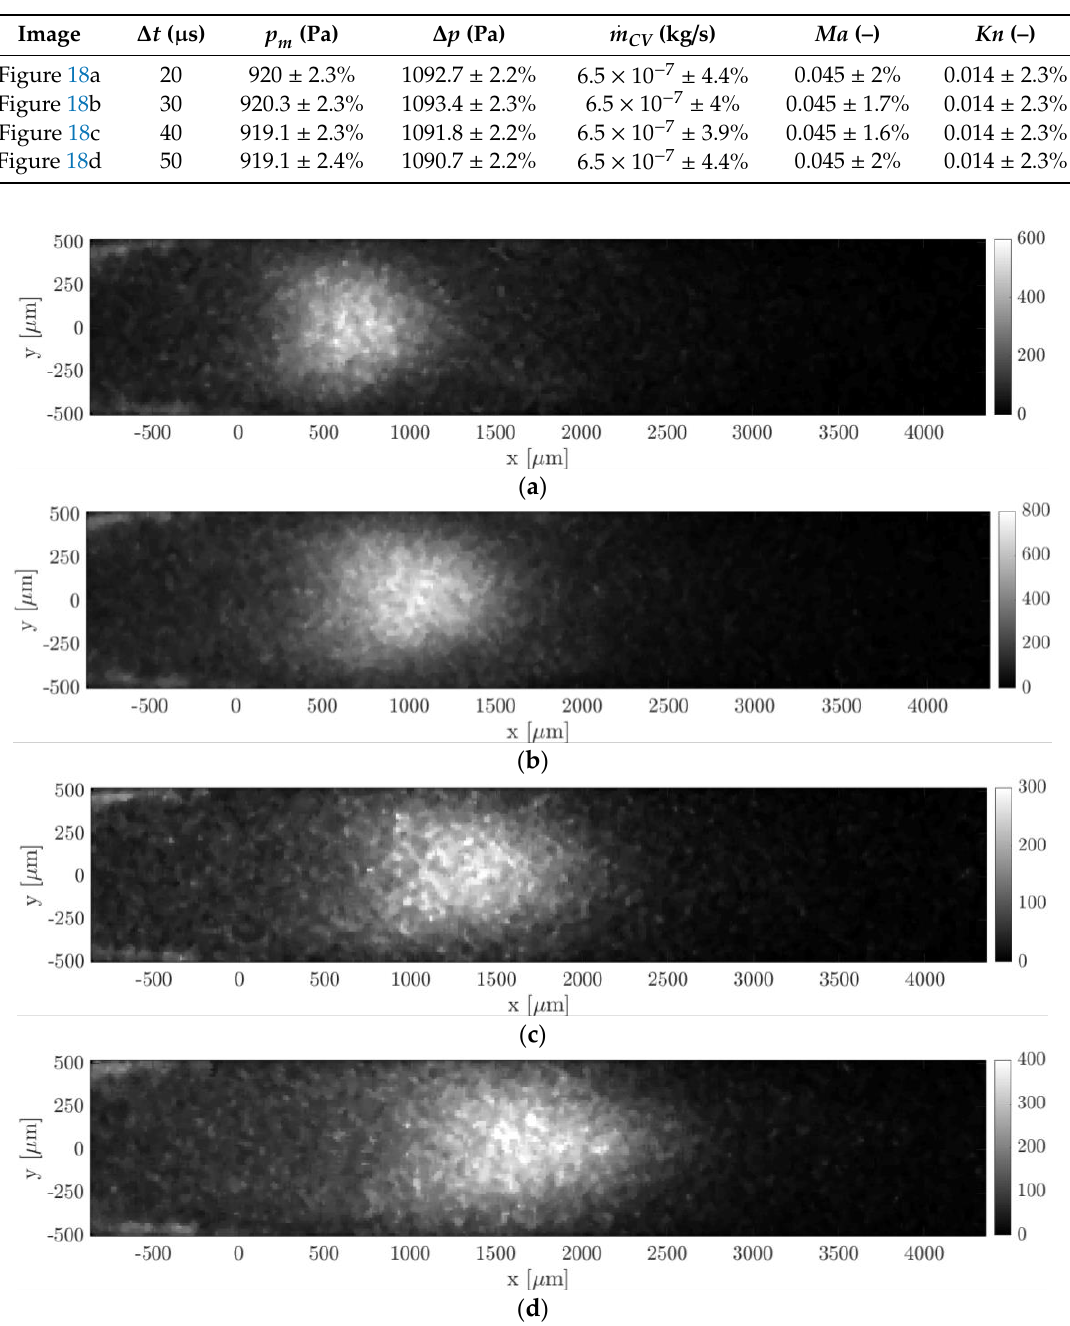
Table 4. Flow properties associated to the images of Figure 18. The reported percentage change indicates how much the properties vary inside the group of 𝑁 𝑖 = 20 average images.